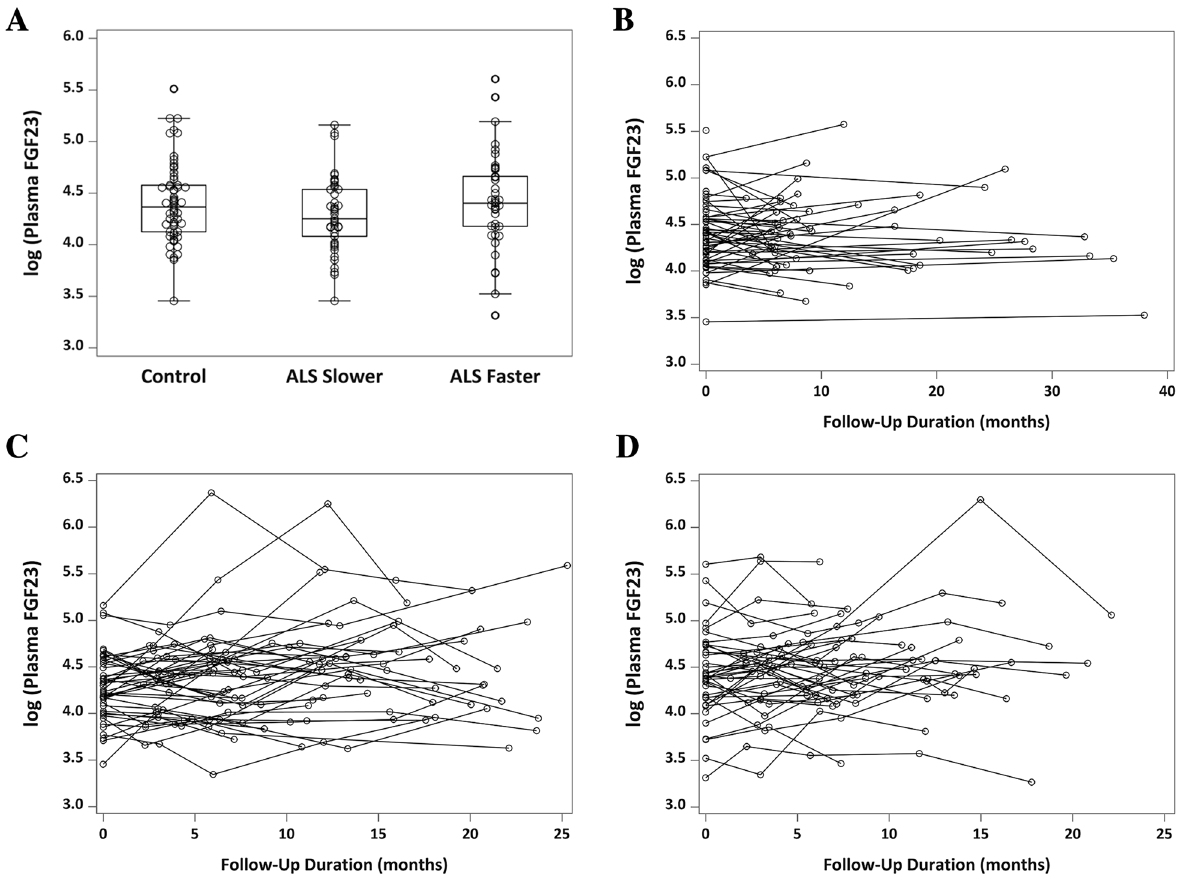
Figure 5. FGF23 in human plasma samples from ALS patients and healthy controls. ( A ) Baseline levels of log-transformed plasma FGF23 concentration (pg/ml) among controls, and faster and slower progressing ALS patients. Boxes show median (middle line), and 25th and 75th percentiles (lower and upper border, respectively); whiskers extend to a maximum of 1.5 × interquartile range (IQR), or to the most extreme value if it is less than 1.5 × IQR from the 25th or 75th percentile. ( B ) Longitudinal changes in log-transformed plasma FGF23 among controls. ( C ) Longitudinal changes in log-transformed plasma FGF23 among ALS